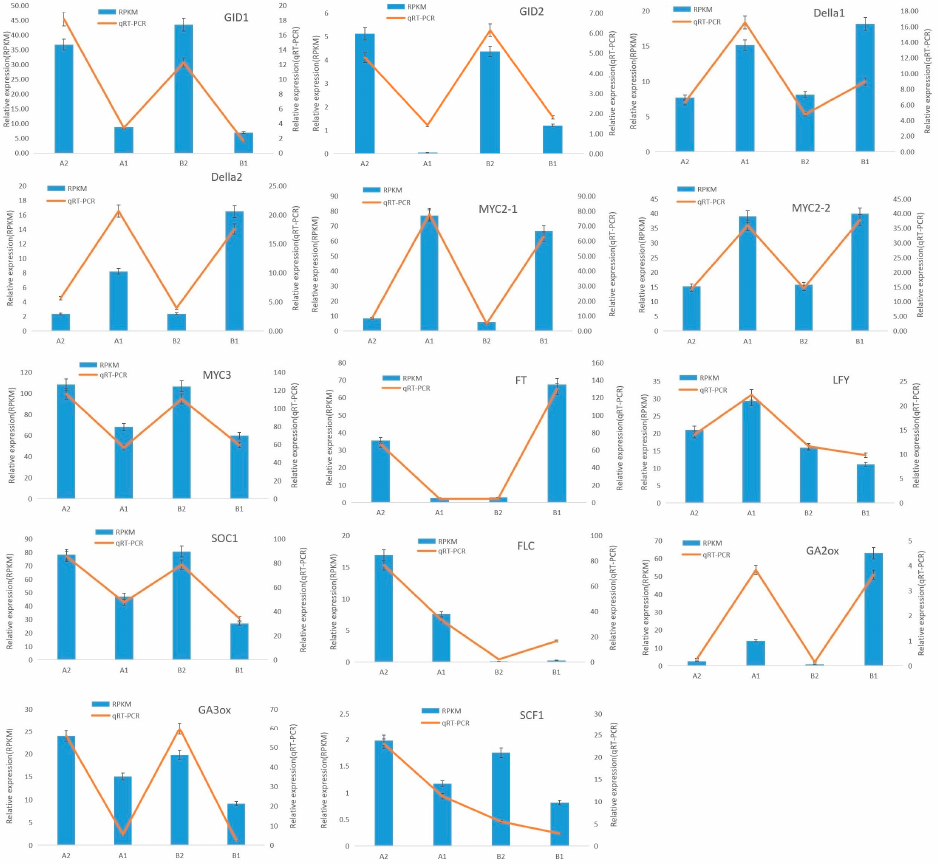
Figure 4. Comparative analysis of qRT ‐ PCR and RNA ‐ seq of candidate genes related to flower bud differentiation in chestnut. Actin was used as the control. The error bars represent the SD of three biological replicates. The numbers above the graphics correspond to values obtained with the correlation analysis of the gene expression ratios obtained from the RNA ‐ seq data (column) and the qRT ‐ PCR data (fold line). A1. The CMF in post ‐ winter. B1. The IMF in post ‐ winter. A2. The CMF in pre ‐ winter. B2. The IMF in pre ‐ winter.